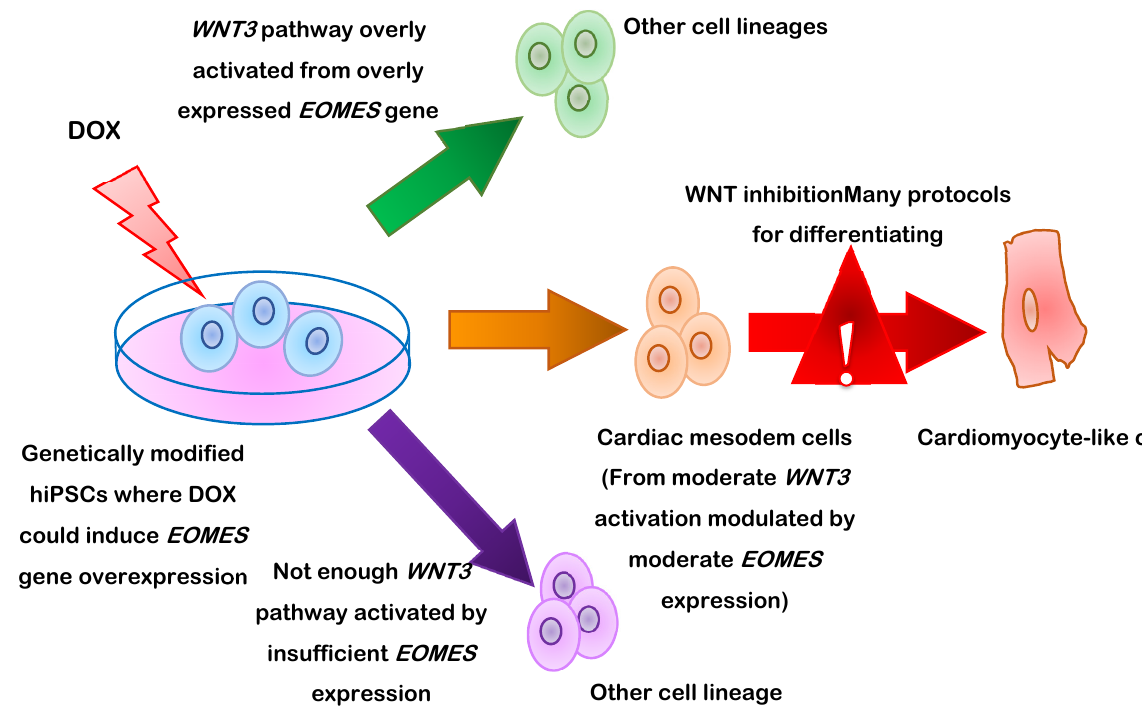
Figure 2. Schematic representation of human induced pluripotent stem cell (hiPSC-CM) differentiation via the manipulation of eomesodermin ( EOMES ) gene expression via a doxycycline (DOX)-regulated promoter.